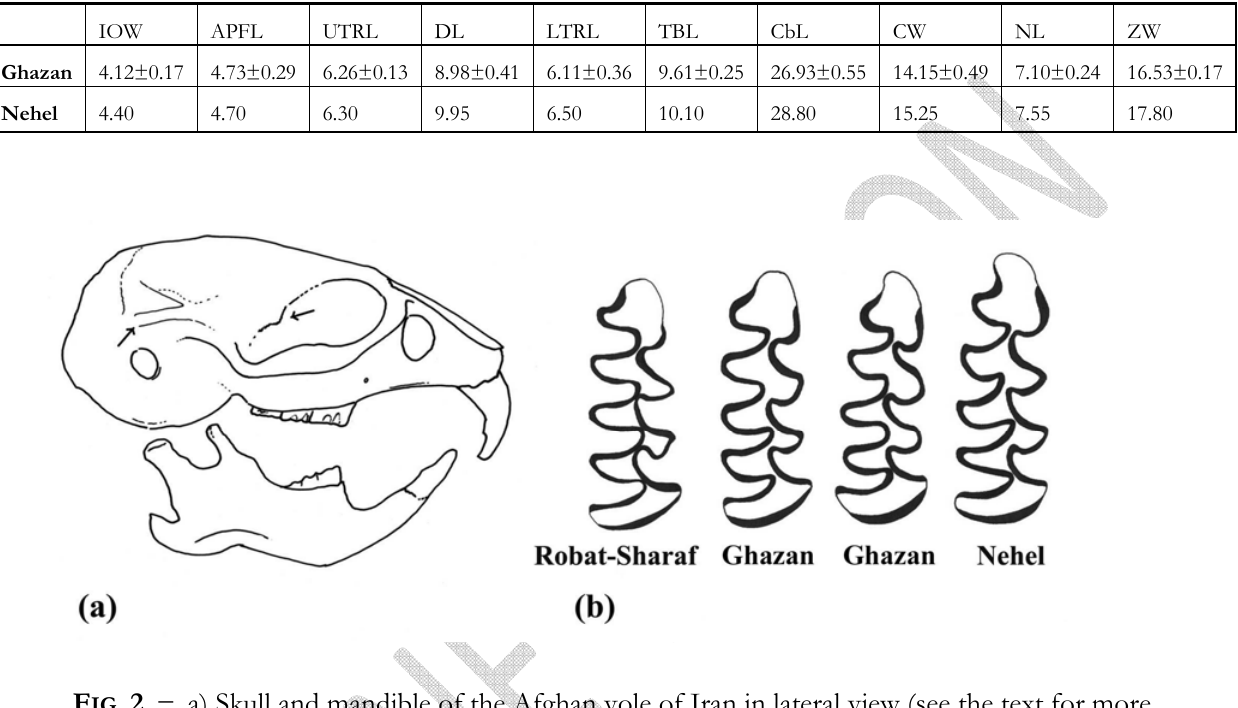
_ a) Skull and mandible of the Afghan vole of Iran in lateral view (see the text for more F IG . 2. information). b) Variation of the first lower molar in Afghan voles of